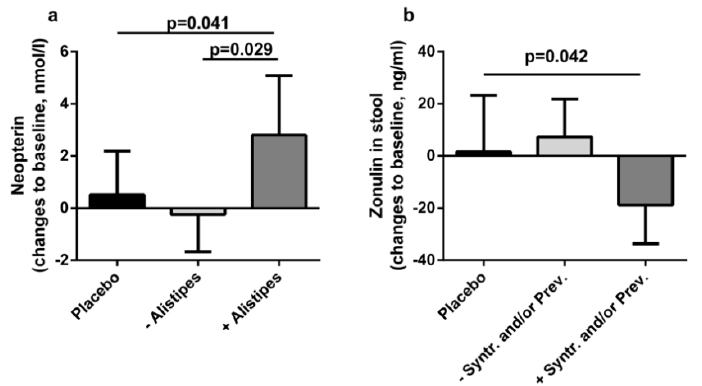
Figure 3. Associations with clinical outcome. ( a ) Changes in serum neopterin levels from baseline to the end of intervention of patients with increased Alistipes abundance ( + ), decreased or unchanged abundance ( − ), or placebo-treated patients. ( b ) Changes in faecal zonulin levels of patients with increased Syntrophococcus and or Prevotella abundance ( + ), decreased or unchanged abundance ( − ), or placebo-treated patients.